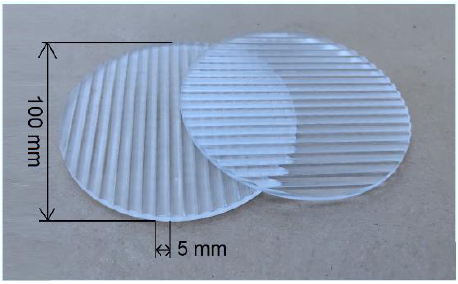
Figure 12. Photograph of the fabricated linear Fresnel lenses.